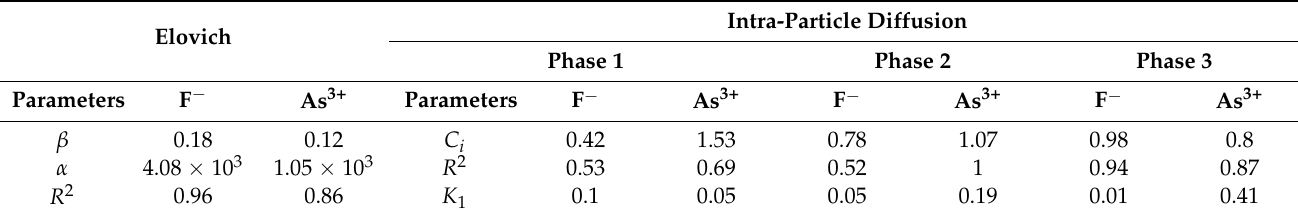
Figure 7. Kinetic models ( a , b ): pseudo-first- and second-order; ( c , d ): intra-particle diffusion of F − and As 3+ respectively onto the Fe-pPD composite. Table 4. Table for linearized kinetics models of F − and As 3+ onto the Fe-pPD